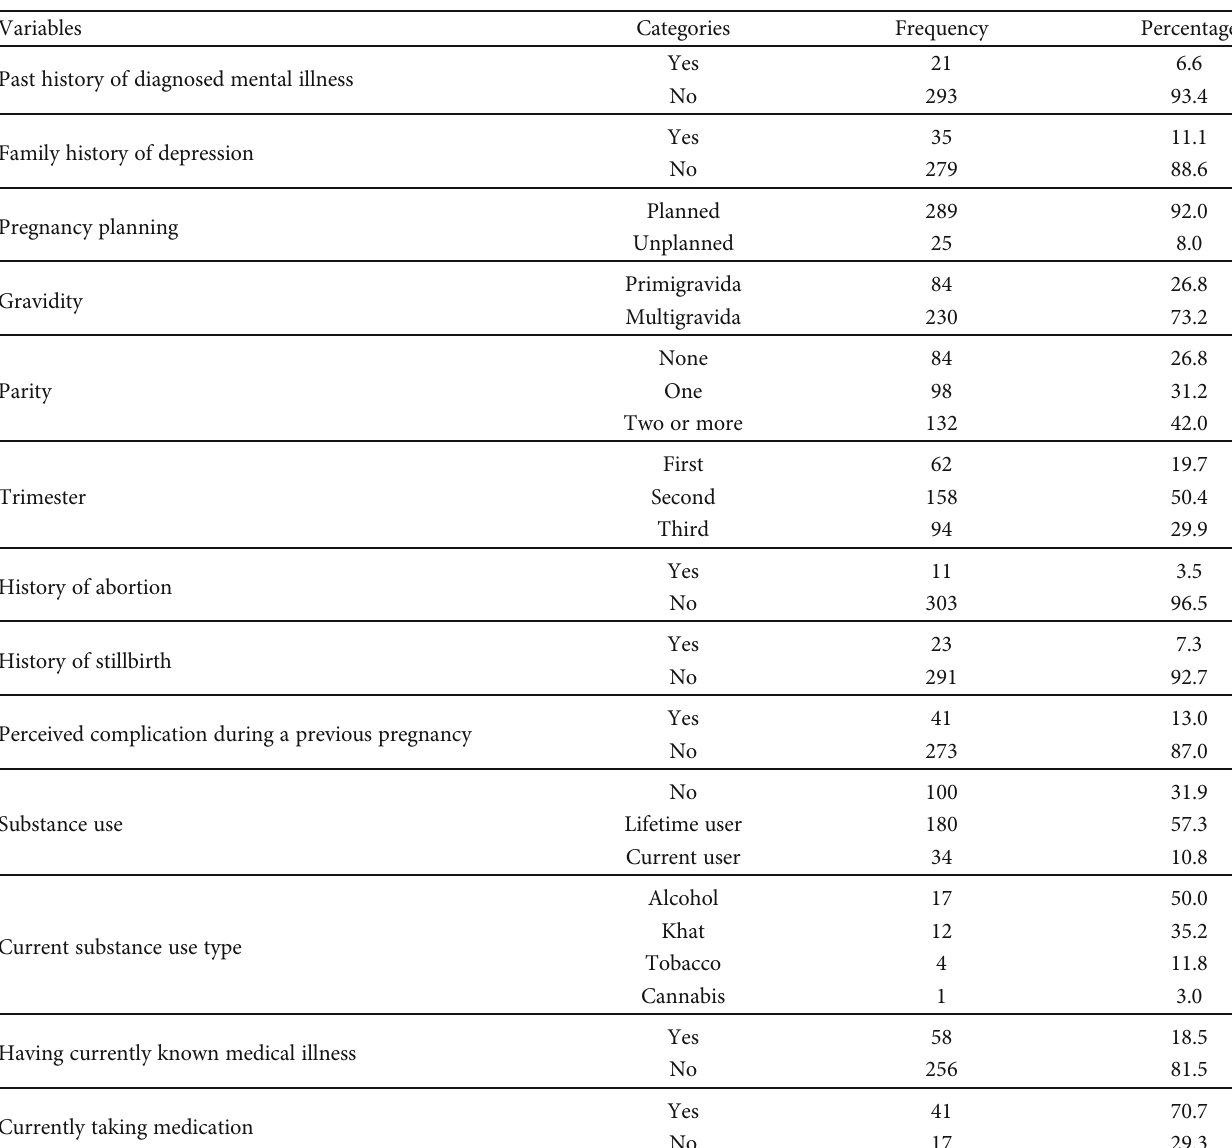
Table 2: Mental, obstetric, and medical characteristics of respondents in Kochi Health Center, Jimma town, southwest Ethiopia,